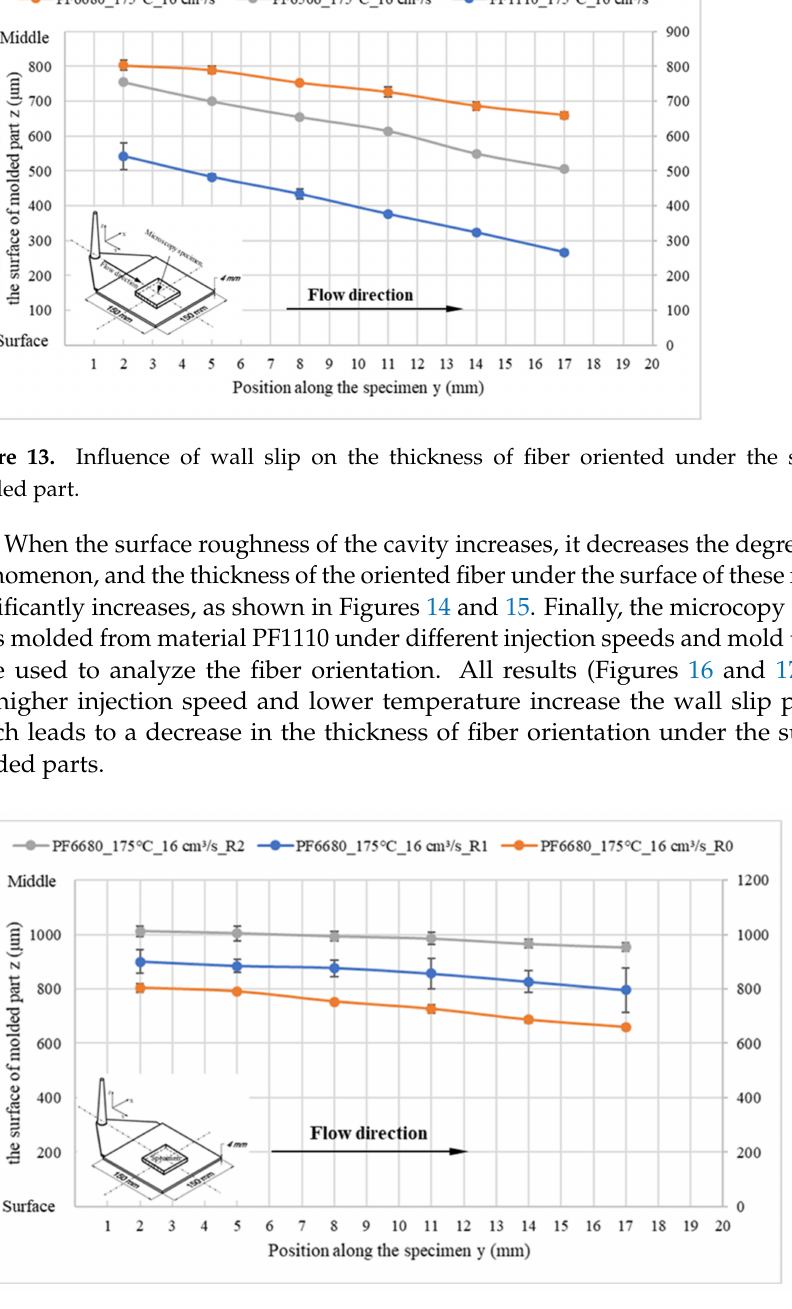
Figure 14. PF6680 (GF25+GB30); the influence of surface roughness on the thickness of the fiber orientation under the surface of molded